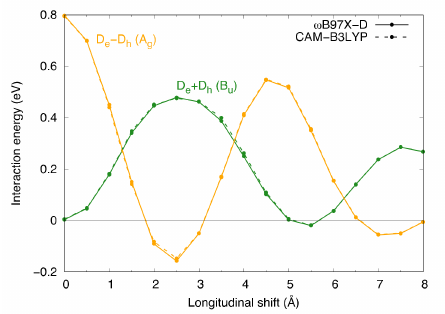
Figure 9. Interaction energies between CR and FE states computed at TDA-CAM-B3LYP/6-31G* (dashed) and TDA- ω B97X-D/6-31G* (solid) levels; (gold) interaction between A g CR and FE states; (green) interaction between B u CR and FE